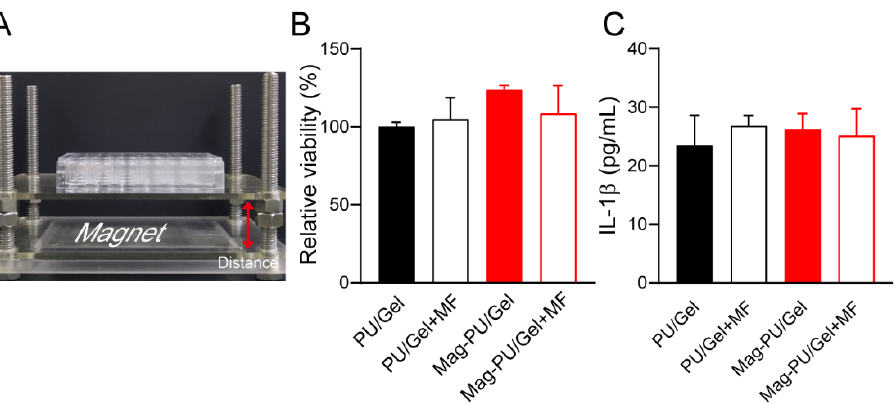
Figure 2. Viability and inflammatory effect of cells cultured under different conditions. ( A ) The cell culture device with magnetic fields. ( B ) The viability of C2C12 cells under different culture conditions. ( C ) The IL-1 β secretion of RAW 264.7 cells incubated with the different scaffolds and magnetic field.